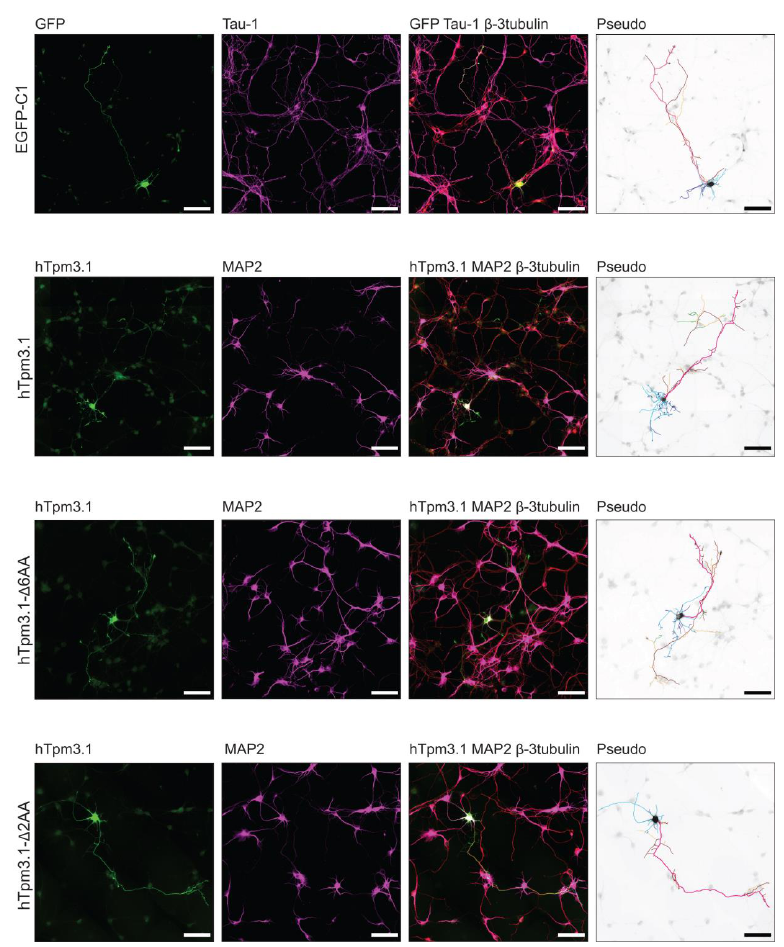
Figure 4. Effects of hTpm3.1 C-terminal truncation on morphology of C57/Bl6 hippocampal neurons. Representative fluorescent images of mouse primary hippocampal neurons expressing EGFP-C1, hTpm3.1, hTpm3.1 ∆ 6AA and hTpm3.1 ∆ 2AA for 48 h, fixed at 4DIV and stained with GFP, Tau-1 and β 3-tubulin antibodies (EGFP-C1 transfected neurons) or LC-1, MAP2 and β 3-tubulin (hTpm3.1, GFP or LC-1 fluorescence images with pseudo-coloured axon and dendrite labelling for clearer visualizations of the compartments. Curves in pink—axonal shaft, burgundy—primary axonal branches, orange—secondary axonal branches, bright green—tertiary axonal branches, dark green— quaternary axonal branches, light blue—dendritic shaft, dark blue—primary dendritic branches, and purple—secondary dendritic branches. Scale bars = 50 µ